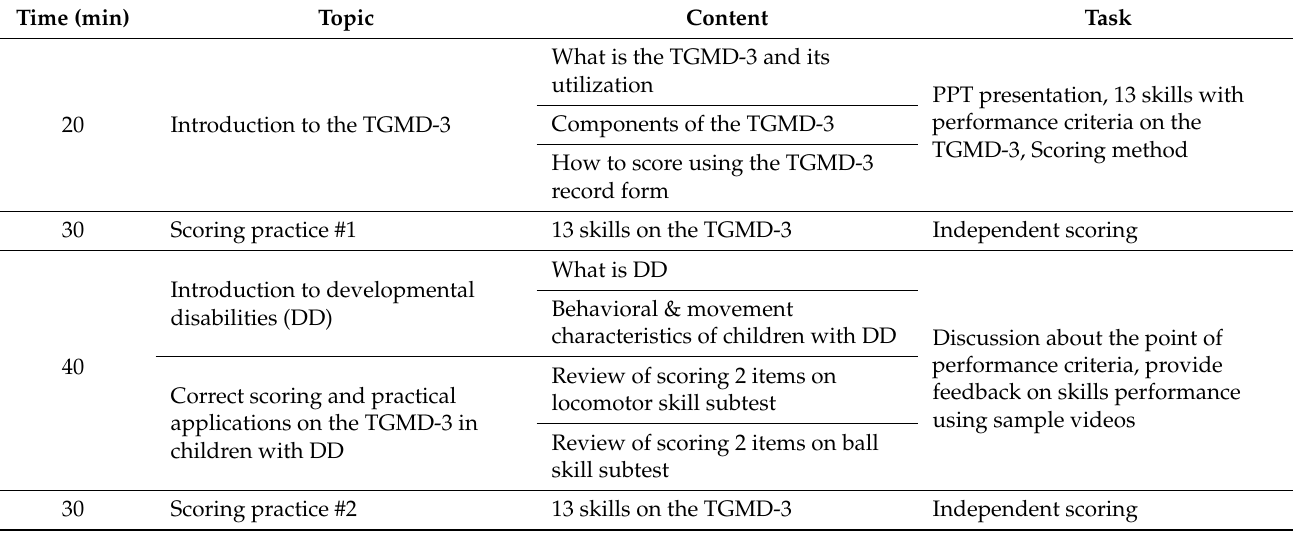
Table 1. Description of the TGMD-3 Rater Training